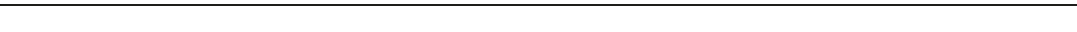
Fig. 5 Validation of impactful PIK3R1 mutation-induced phenotypes related to proliferation and drug response. a The frequencies of impactful PIK3R1 mutations (proliferation, doxorubicin, and BKM120 responses) in the FUSCC, COSMIC, and TCGA data sets. b The locations of the identi fi ed impactful amino acid substitutions in the SH3, Rho-GAP, nSH2, iSH2, and cSH2 domains of PIK3R1 are illustrated (Proliferation, black; doxorubicin, red; BKM120, blue). c The locations of the impactful mutations in the dimensional structure of the PIK3R1 -encoded p85 α protein are illustrated. Colors denote mutant residues within the corresponding domains in b . d Growth curves were determined in MCF-10A cells expressing PIK3R1 wild-type and mutants in the absence of EGF (up) or presence of EGF (down). The error bars shown are mean ± s.d. of 5 technical replicates from a representative of three independent experiments. (* P < 0.05, for Student ’ s t test). e Effects of PIK3R1 mutations on mammary acinar morphogenesis. The dot plot shows the size distribution and the mean (horizontal line) for each cell line. ( n ≥ 3, >60 acini per experiment; Mann – Whitney test: *** P < 0.0001; n.s. not signi fi cant). Scale bar, 100 µ m. f Activation status of the PI3K pathway in the indicated cells 24 h after growth factor (EGF and insulin) withdrawal. The cells were lysed and immunoblotted with the indicated antibodies. Western blots were representative of three independent experiments. g Activation status of p-AKT (Ser-473) after the addition of increasing concentrations of BKM120 to the indicated cell lines. The cell lines were cultured in starvation medium for 24 h and then treated for 1 h with increasing concentrations of BKM120. Western blots were representative of three independent experiments. h , i Growth curves of MCF-10A cells expressing PIK3R1 wild-type and mutants with doxorubicin or BKM120. Five wells were measured per condition. Error bars represent mean ± s.d. derived from three independent experiments. (** P < 0.01, for Student ’ s t